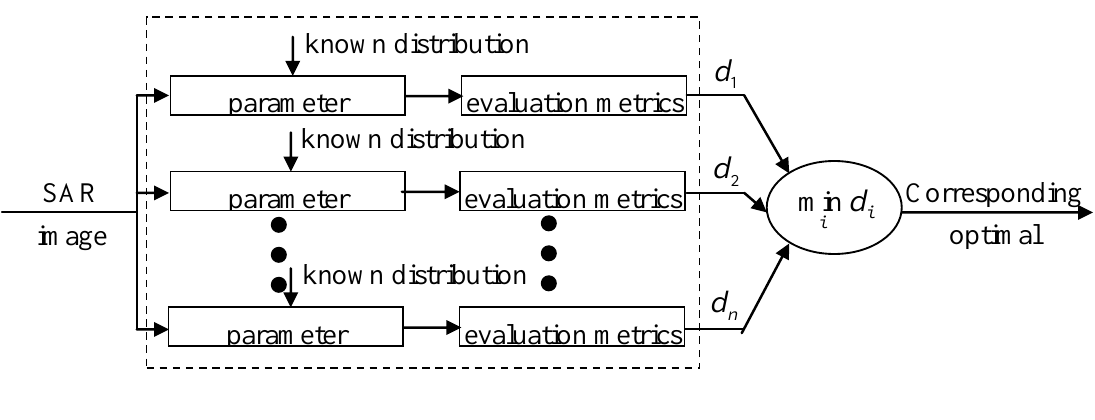
Figure 1. A general flow chart of parametric